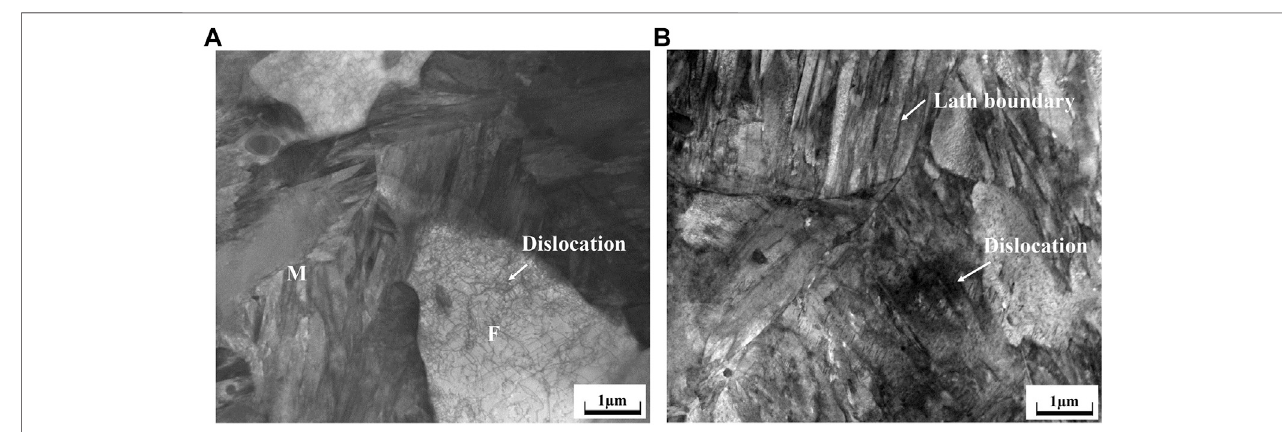
FIGURE 3 | TEM images of DP steel with 68.3% martensite content: (A) Dislocations in the ferrite region around the F/M boundary; and (B) dislocations and lath boundaries in the martensite.